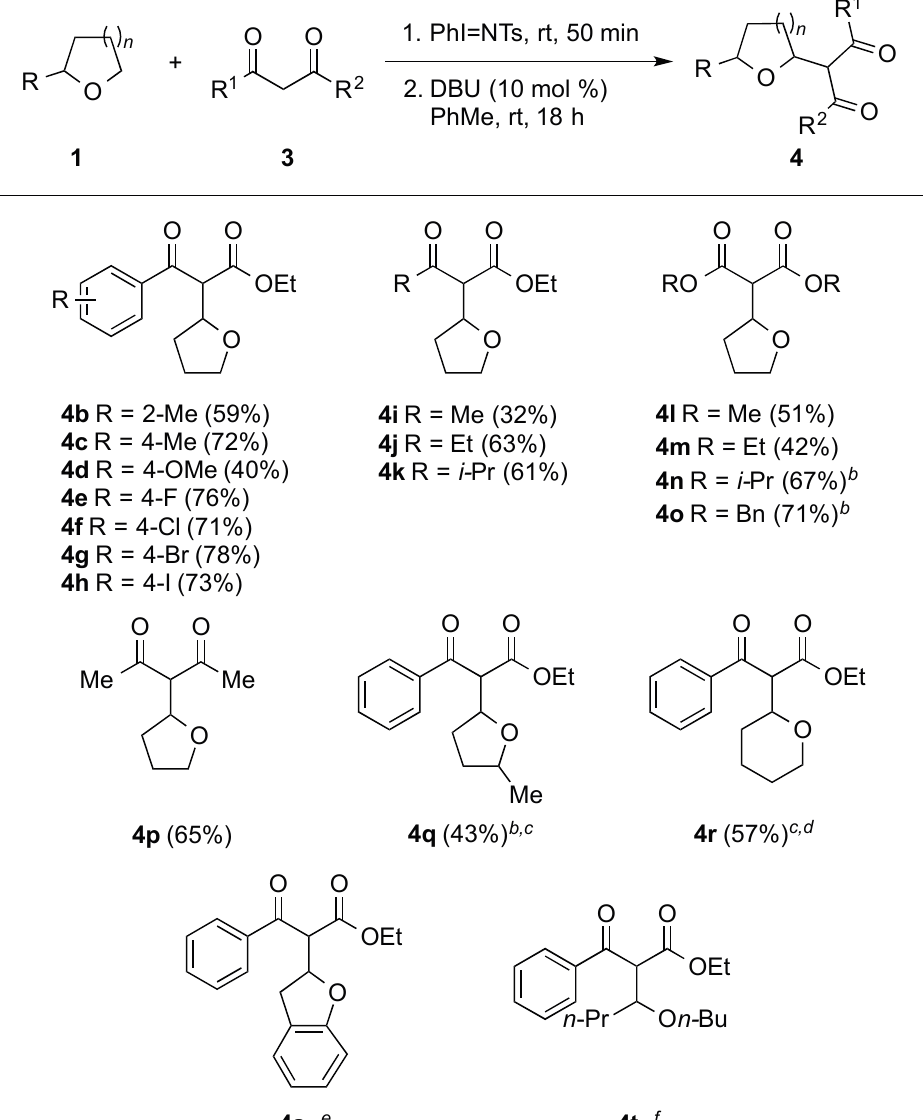
Figure 1. Iminoiodane-mediated CDC reactions of cyclic ethers 1 and 1,3-dicarbonyl compounds 3 a